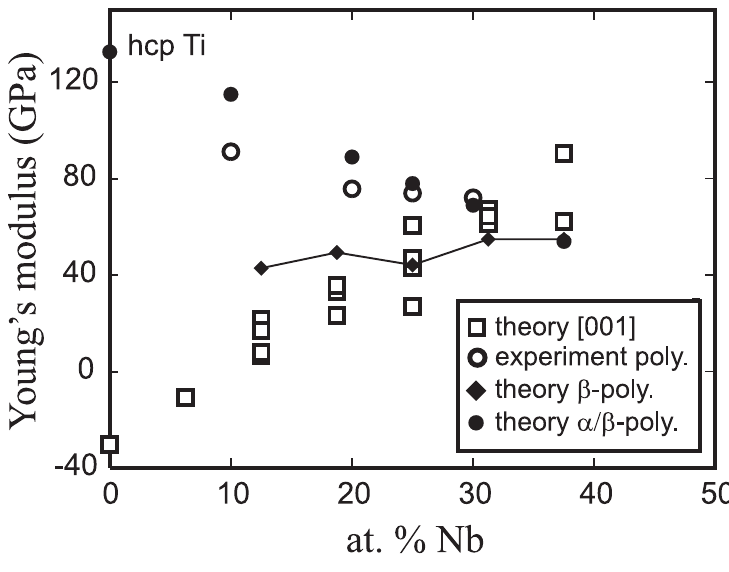
Figure 5. Predicted and experimentally obtained Young’s moduli. The theoretical single- crystal Young’s moduli for the soft [001] crystal direction of the cubic lattice cell are shown by empty squares. The homogenized Young moduli of hypothetical β -phase polycrystals with varying Nb content (not from the Gibb’s construction) are shown by full diamonds connected by a line. Full circles stand for the predicted Y ∗ visualized by empty